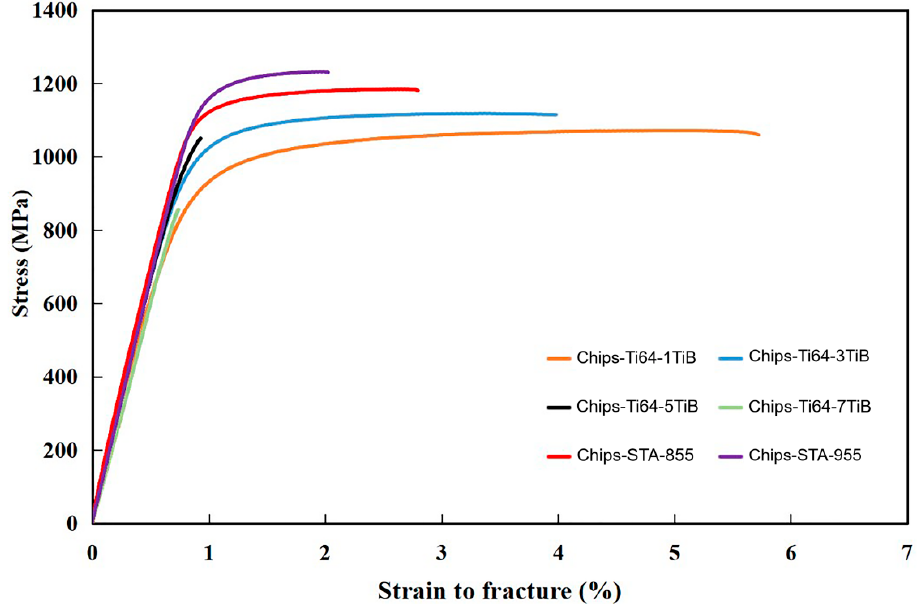
Figure 9. Room-temperature stress-strain curves of Chips-Ti64-xTiB composites and Chips-Ti64-3TiB after different heat treatments.